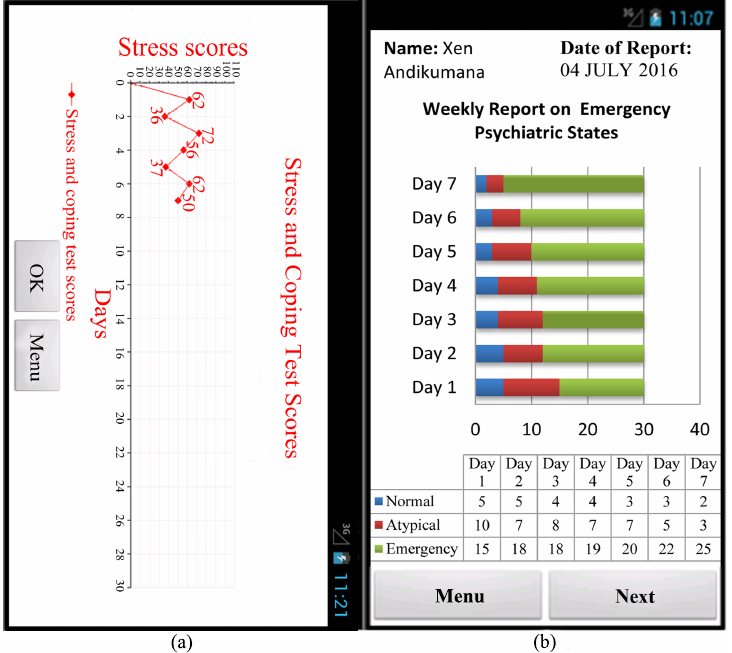
Figure 14. Mental health report generated through the WoO-based prototype AAL framework: ( a ) Monthly report on stress level; and ( b ) Weekly report on the prognosis of emergency psychiatric